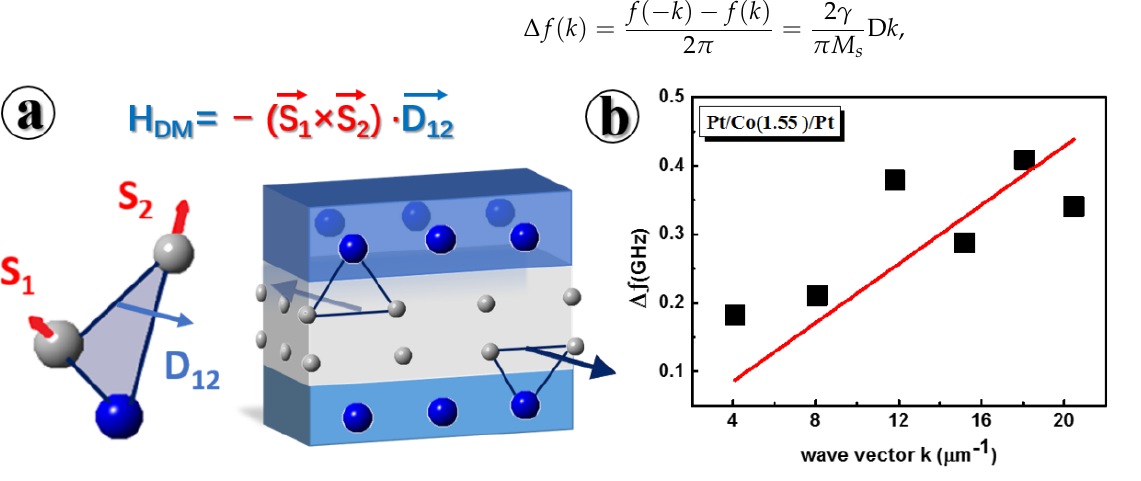
Figure 2. The interfacial Dzyaloshinskii–Moriya constant in symmetric Pt/Co(1.55)/Pt multilayers measured by Brillouin spectroscopy. ( a ) The schematic multilayers illustration composed of a mag- netic Co layer (grey) sandwiched between two heavy metal layers of Pt (blue) with the possible DMI construction for neighbor atoms. Ideally, the total effective DMI by using the symmetric Pt/Co(t)/Pt multilayer as the repeating unit should be canceled because the top and bottom interfacial DMI exhibit the same magnitude but the opposite sign. ( b ) Frequency difference of counter-propagating spin waves as a function of wave vector in Pt/Co(1.55)/Pt multilayers, fitting well to the solid line based on Equation (2). D = 0.23 mJ/m 2 is calculated from the slope by linear correlation. Symbols denote measured data.